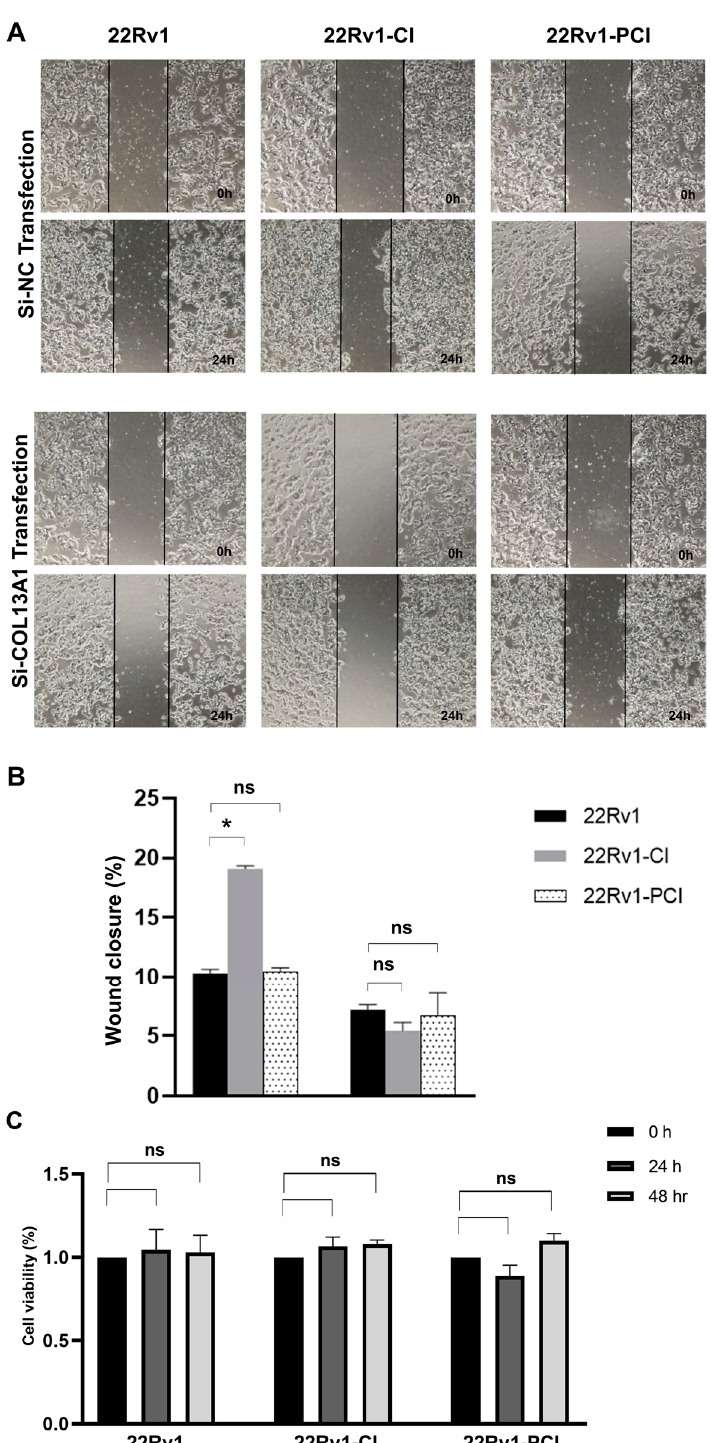
Figure 5. Wound healing assay of 22Rv1, 22Rv1-CI, and 22Rv1-PCI cells transfected with si-NC or si-COL13A1. ( A ) Representative image of wound healing assay in control and hypoxia-resistant cells. ( B ) Bar graph represents the percentage of scratch closure. ( C ) Cell viability assay of 22Rv1, 22Rv1-CI, and 22Rv1-PCI cells transfected with si-NC and si-COL13A1. Data are mean ± SEM. * p < 0.05; ns, not significant.